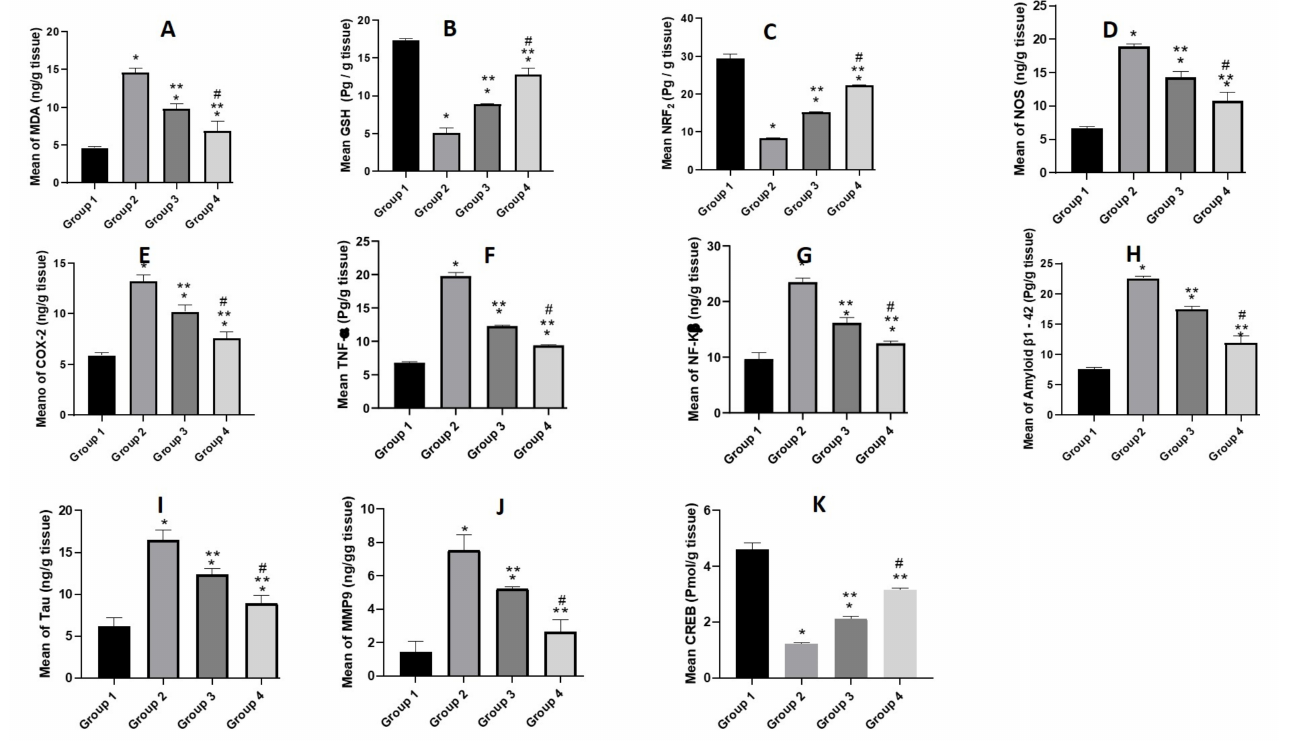
Figure 10. Biochemical assay where animals under investigation were divided into 4 groups; the first one was the normal control group. The second group was the positive control model group that received STZ (3 mg/kg, ICV). The last two groups were all ICV-injected first with STZ (3 mg/kg) followed by i.n. injection with luteolin suspension (50 mg/kg, for 21 days), and luteolin loaded chitosomes (50 mg/kg, i.n. for 21 days), respectively. The brains of the animals (n = 8) in each group were homogenized then centrifuged, and supernatants were used in the oxidative stress parameters assay of ( A ) mean MDA concentration, ( B ) GSH level and (C) NRF2 level. The proinflammatory mediators’ assay of ( D ) mean NOS level, ( E ) COX-2 level ( F ) TNF- α level, and ( G ) NF-K β levels. The amyloidogenicity and tauopathy of ( H ) mean of Amyloid β 1-42 level, and ( I ) Tau level. Finally, ( J ) MMP9, and ( K ) CREB level. Statistical analyses were performed using ANOVA followed by the Tukey post hoc test, whereby each value was expressed as mean ± SD. * Statistically significant difference from the normal group ( p < 0.05); ** statistically significant difference from the STZ model group, ( p < 0.05); # statistically significant difference from the LUT susp group 50 mg/kg ( p <